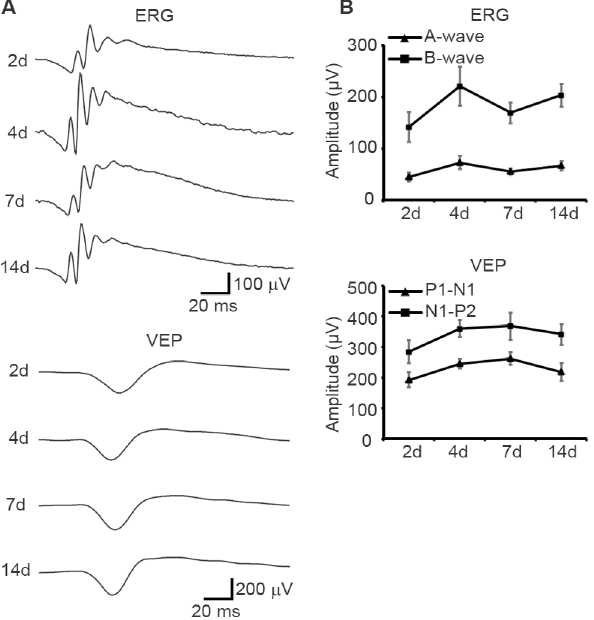
Fig 5. Stability of the ERG and VEP recording. A, B, Amplitude time courses of ERG and VEP waveforms recorded in anesthetized mice ( N = 4 for each time point). The flashes (0 log cd/m 2 ) were given in the scotopic condition. The bars indicate mean ±